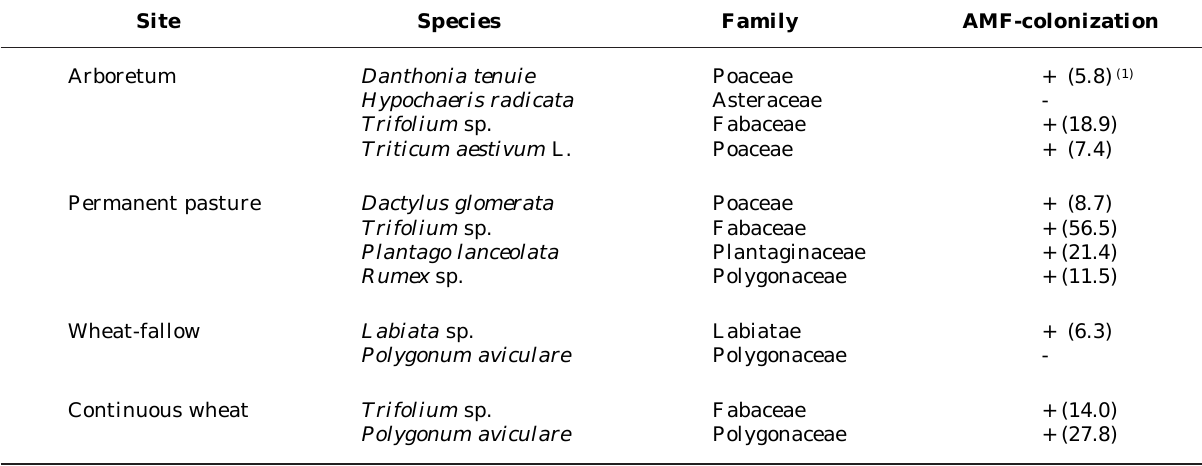
Table 3. Percentage of root length infected by AMF of volunteer plants sampled from four different sites at Waite Campus, in July, 1996